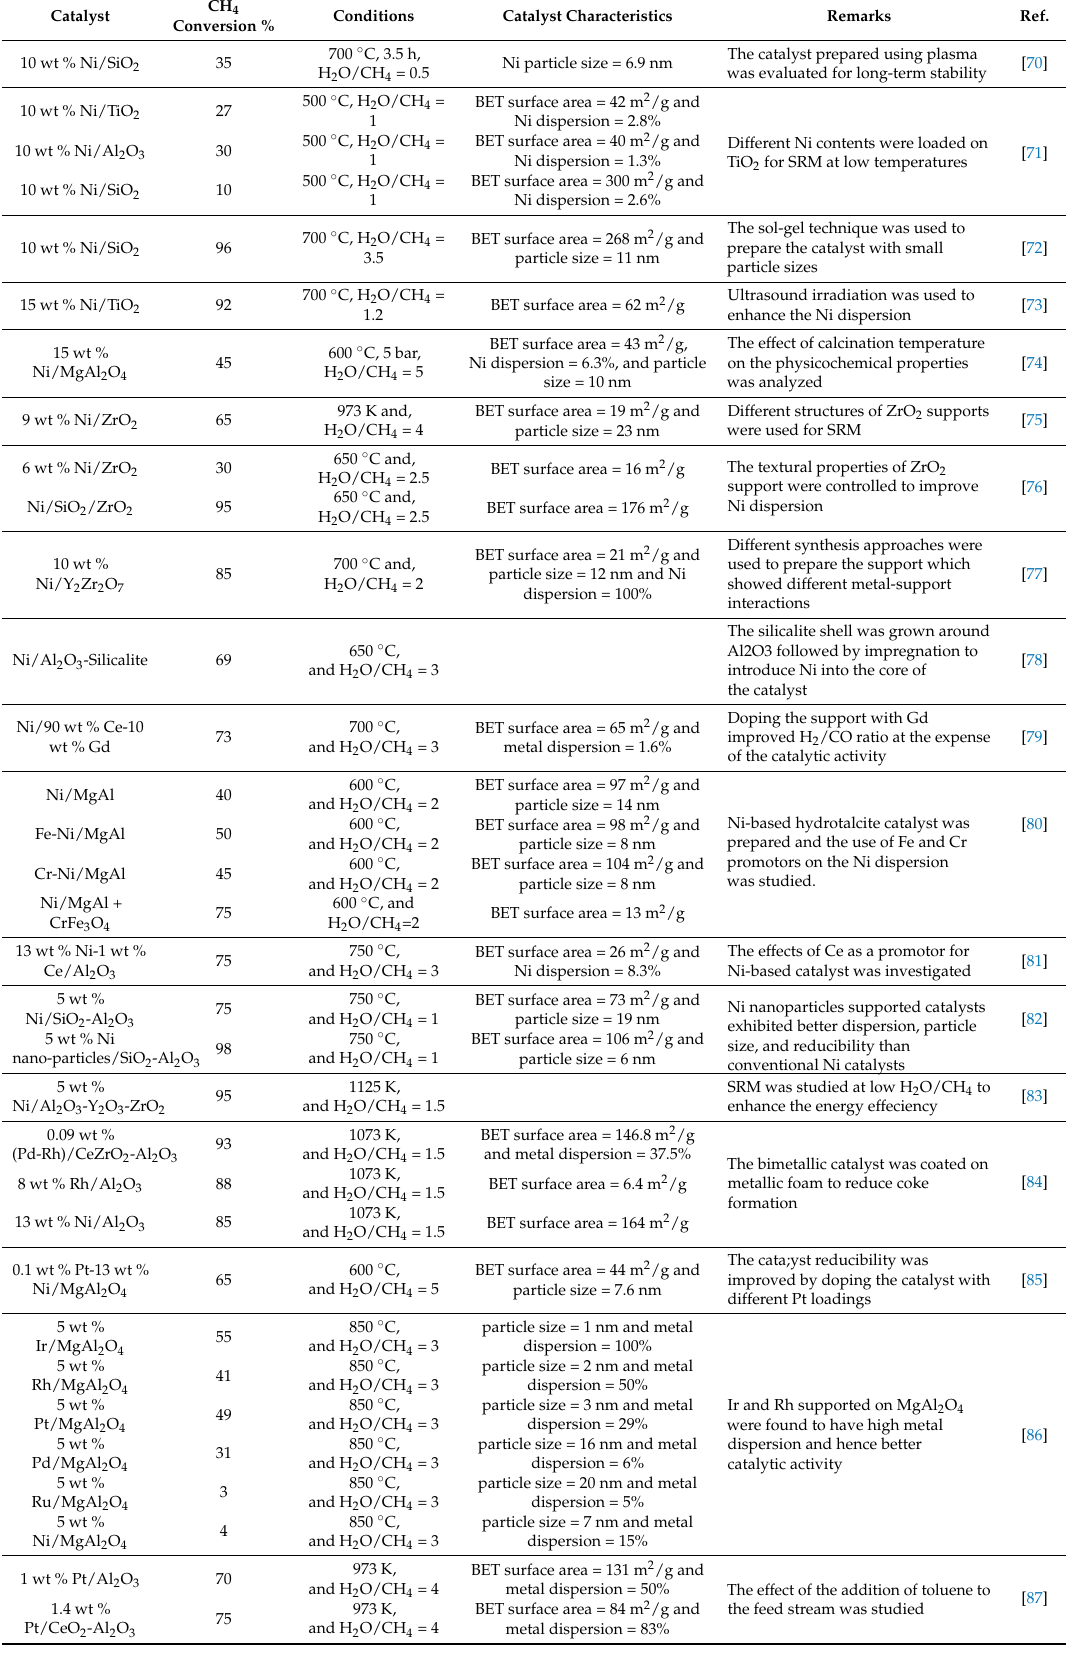
Table 4. Summary of Catalysts used for steam reforming of methane